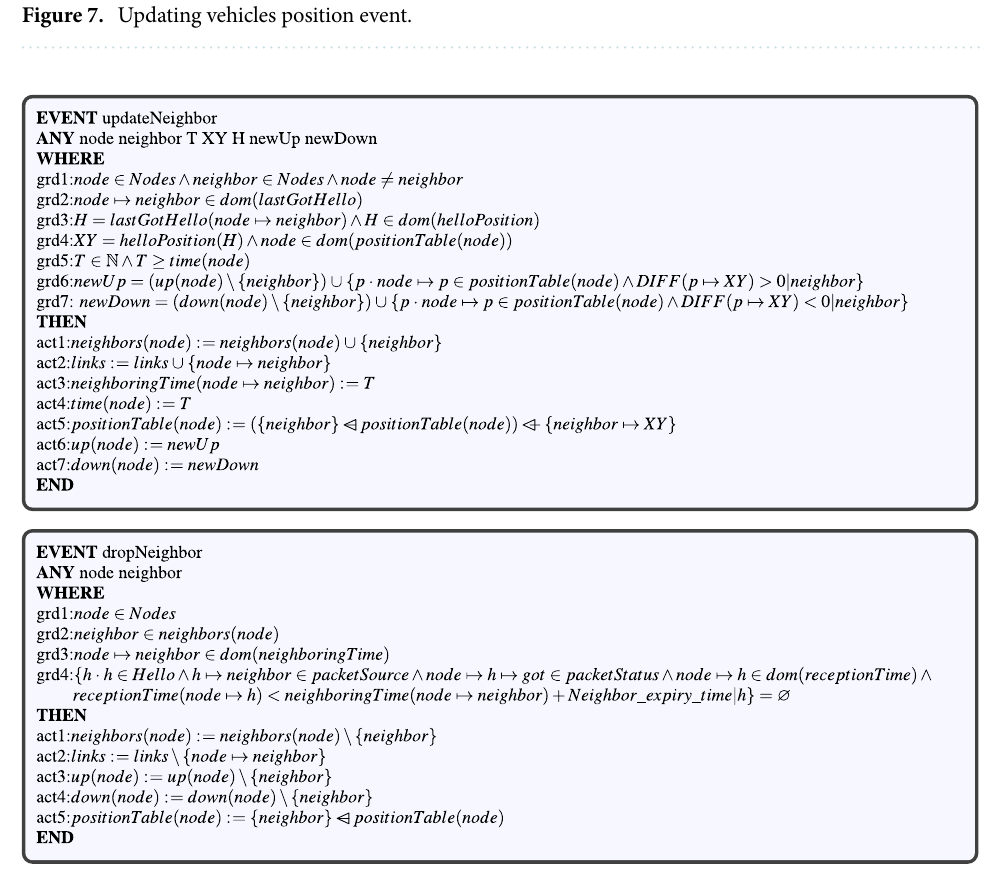
Figure 8. The neighbor updating/removing